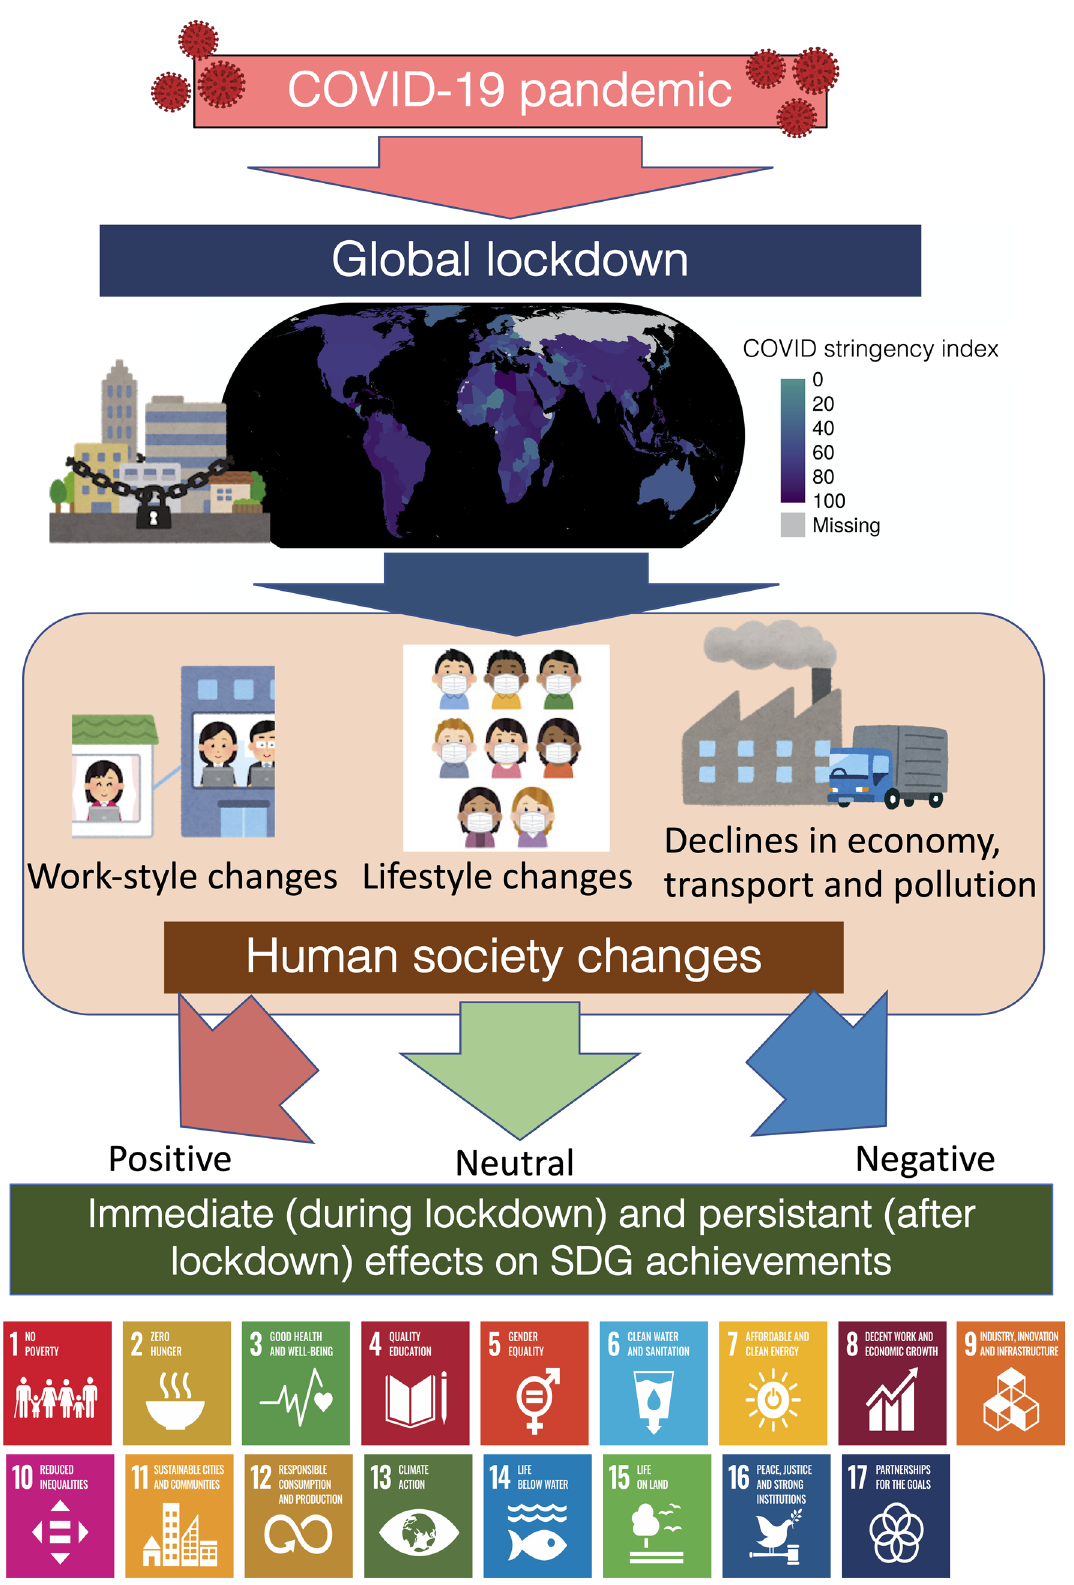
Fig. 1 Conceptual illustration of the COVID-19 pandemic effect on SDG achievements through global lockdown consequences of societal changes. The COVID-19 GRSI is used as the lockdown degree index for each country on 15 June 2020. Illustrations are adopted from Irasu- toya (https:// www. irasu toya. com), except for SDG icons and the figure. SDG icons are adopted from https:// www. globa lgoals. org/ resou